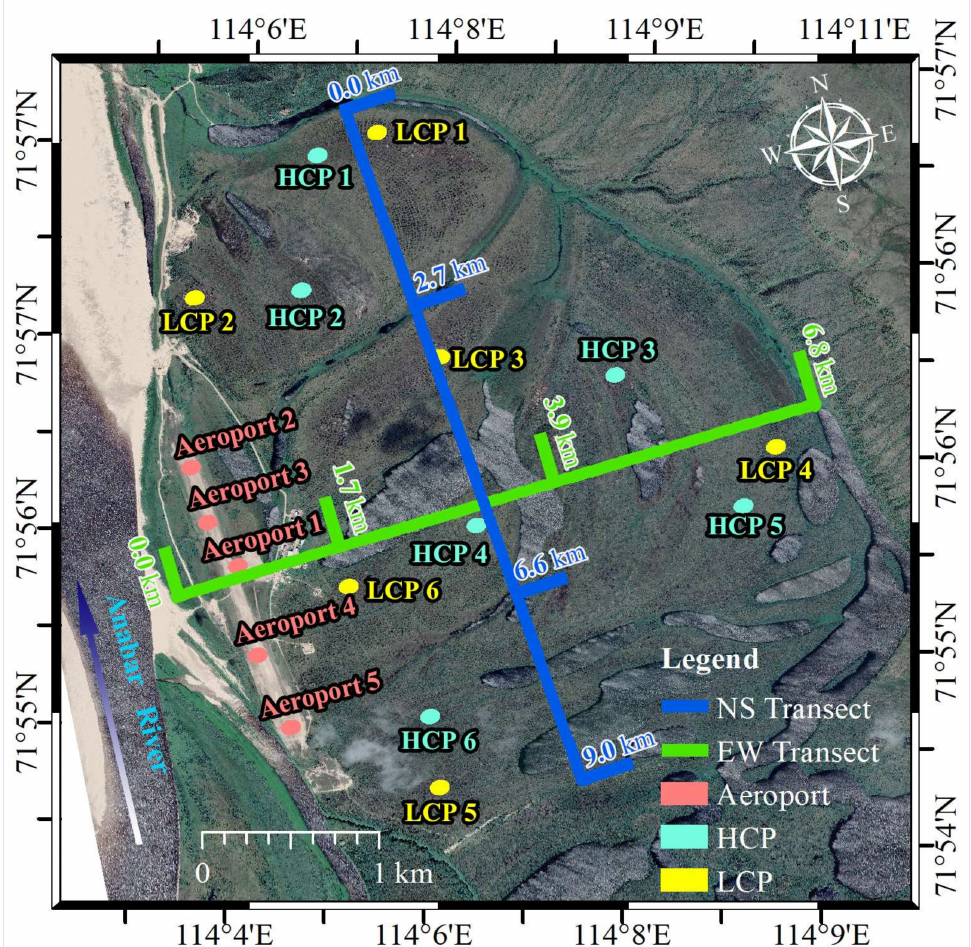
Figure 2. Locations of different types of ice-wedge polygons (IWPs) and N–S and W–E transects in Saskylakh, northwestern Yakutia, Siberian Arctic, Russia. Notes: (1) LCP: low-centered polygon; (2) HCP: high-centered